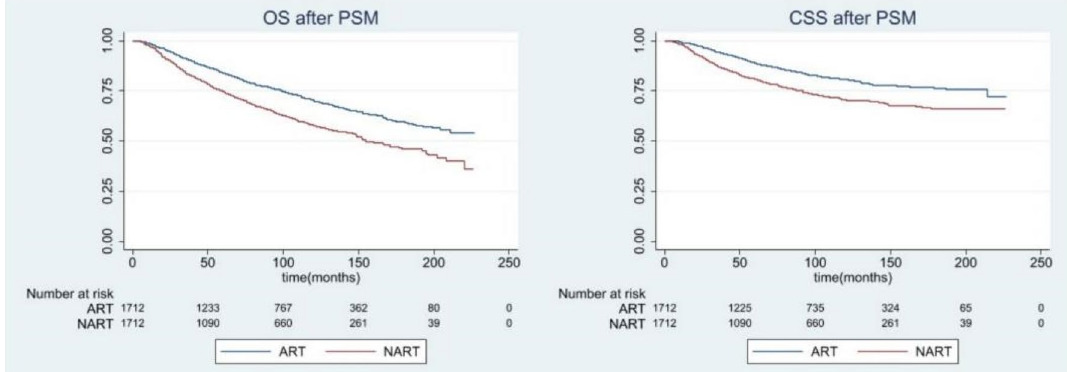
Figure 2. Overall and breast cancer-specific survival by radiation sequence with surgery among the whole cohort after